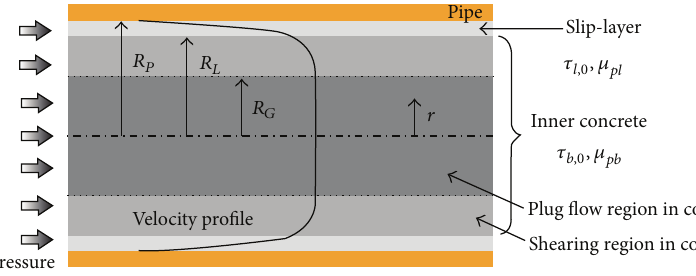
Figure 1: Profile of concrete flow in a pipe